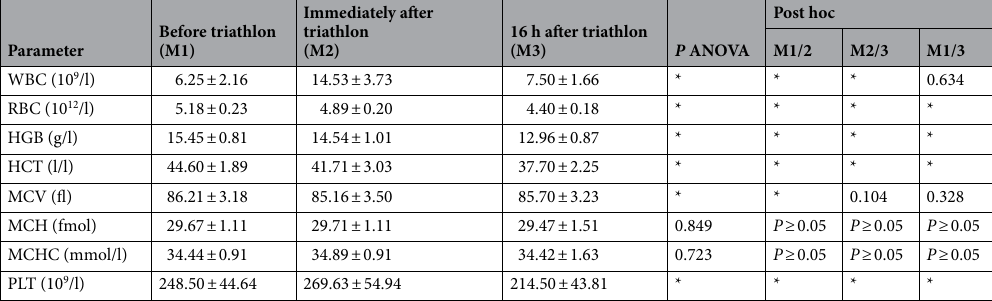
Before triathlon versus immediately after triathlon Immediately after triathlon versus 16 h after triathlon Before triathlon versus 16 h after triathlon − 10.94 ± 8.10 Between the ‘before triathlon versus immediately after triathlon’ and ‘immediately after triathlon versus 16 h after triathlon’ changes: P + 0.2703 Between the ‘before triathlon versus immediately after triathlon’ and ‘before triathlon versus 16 h after triathlon’ changes: P = 0.0027* Between the ‘immediately after triathlon versus 16 h after triathlon’ and ‘before triathlon versus 16 h after triathlon’ changes: P = 0.0905 Table 3. Percentage changes in plasma volume in the 3 performed measurements. *Significant difference ( P = 0.0020).